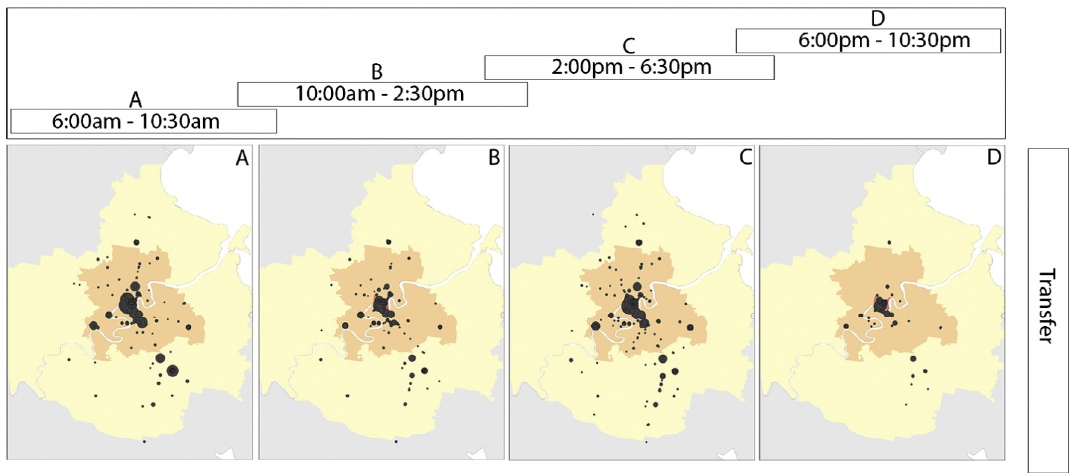
Figure 13. The flow-comap visualization technique for exploring spatiotemporal mobility patterns